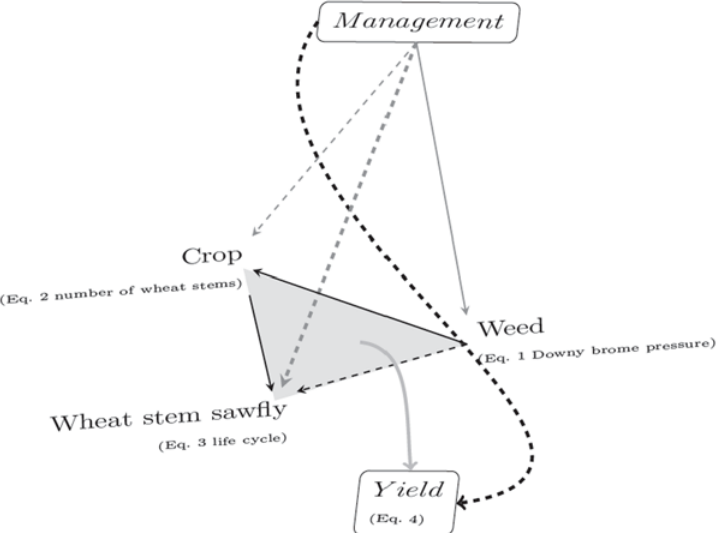
Fig 1. Graphical depiction of the decision model of direct and total effects used to assess the joint effect of Bromus tectorum , Cephus cinctus , and crop management practices on wheat yield. Equations 1 – 4 are described in the text. In this model, solid arrows describe direct effects, dashed arrows represent total effects. Aggregation of model components to output is represented as a curved edge, and the gray triangle denotes the collective impact of complex interactions on crop